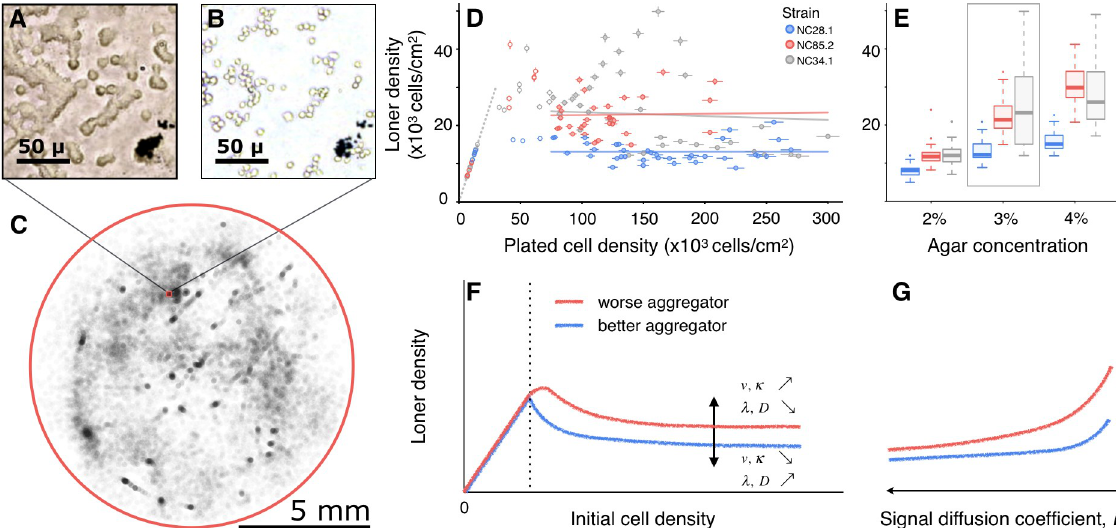
Fig 1. Loners are a heritable component of D . discoideum fitness. (A, B) After aggregation, loner cells are hard to individualize (A), but boundaries between cells become visible after processing (B). (C) Map of the position of each loner cell in an experiment (NC85.2 developing in 3% agar). Red square marks the region shown in A and B. (D) Loner densities of 3 strains as a function of initial plated density in 3% agar. Error bars, independent estimates of counting error (see Materials and Methods). Lines correspond to linear regressions using only high- initial–density data points (solid circles, > 75,000 cells/cm 2 ). (E) Loner densities from experiments with high initial cell density as a function of substrate agar concentration (y-axis same as in D). Boxes, interquartile ranges; horizontal lines, medians; whiskers, 1.5 × interquartile range from the median; points, outliers. Strain NC28.1 always left fewer loners ( t test, p < 0.001). Values inside the frame correspond to data used in (D). (F, G) Schematic of model results showing loner densities as a function of initial cell density (F) and signal diffusion coefficient (G). The y-axis in (G) is the same as in